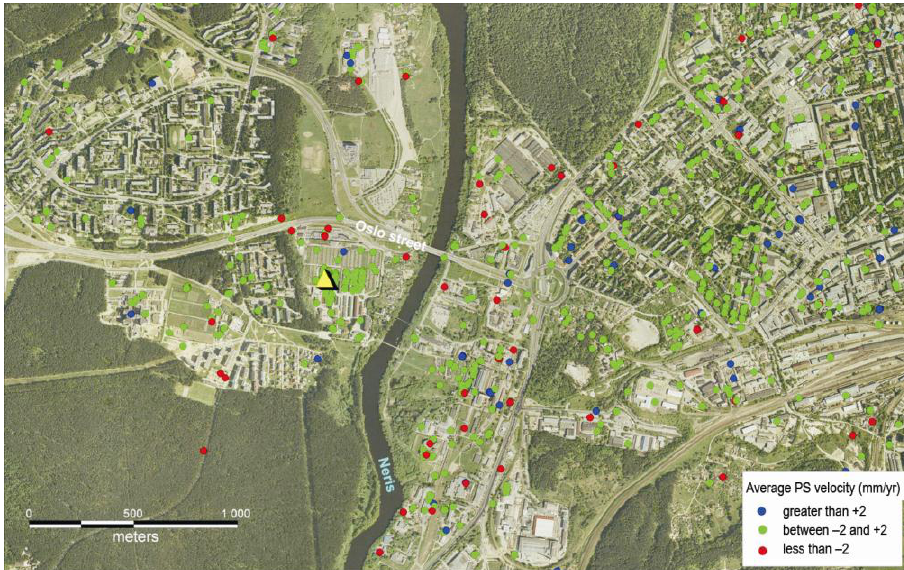
Fig. 2. PS – reference point (shown by yellow triangle), located in the Lazdynai area near the northern bank of the Neris River, close to the important transportation route – Oslo Street, PS with negative velocities below – 2 mm/yr are represented by red dots, PS with velocities exceed- ing +2 mm/yr are in blue colour, stable points between – 2 mm/yr and +2 mm/yr are in green. Background image is a high resolution orthophoto